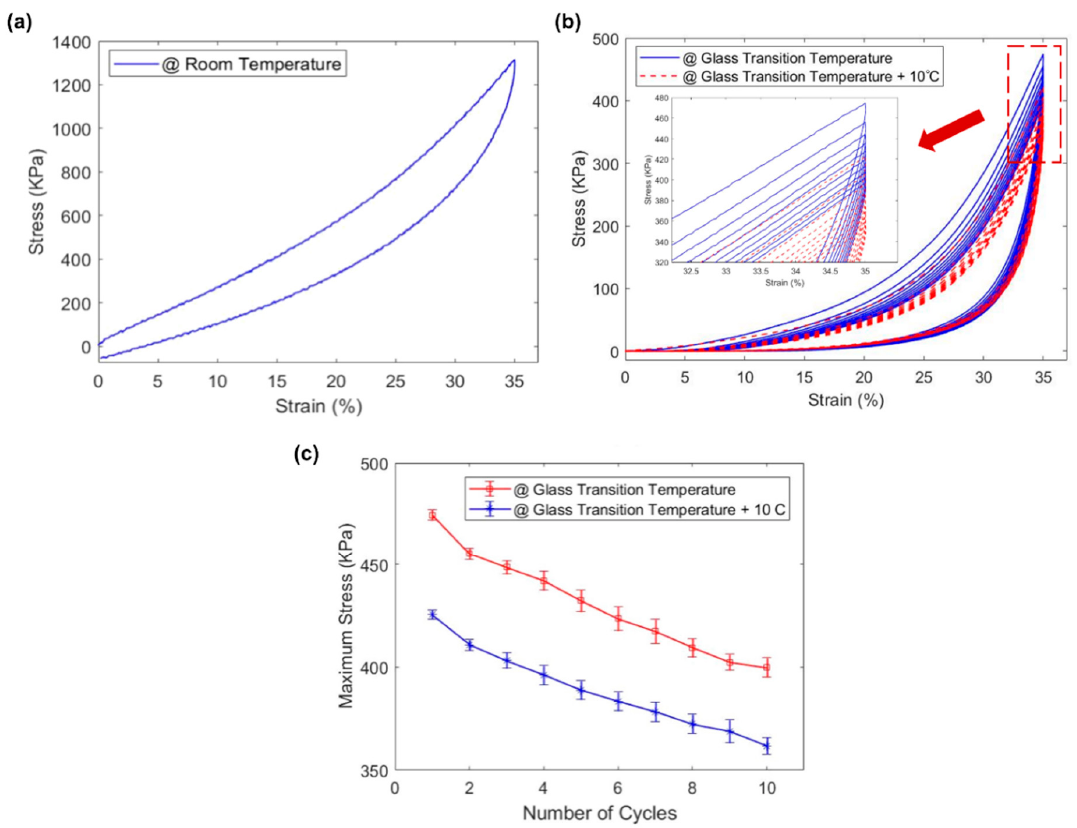
Figure 7. Mechanical characterizations of the fabricated SMP foam under the cyclic compressive loading conditions: ( a ) the typical mechanical response of the SMP foam at room temperature; ( b ) representative mechanical responses of the SMP foam at T g and T g + 10 ◦ C under cyclic compressive loading, and ( c ) comparison of the maximum stress at the 35% strain for various loading cycles at T g and T g + 10 ◦ C. Values are reported as mean ± SEM (standard error of the mean; n = 3).